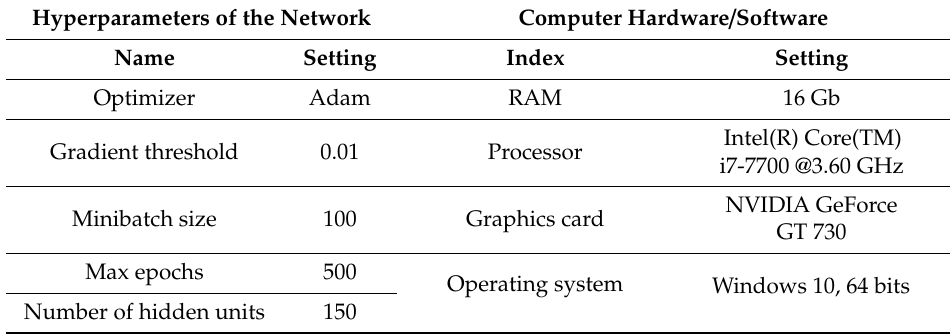
Table 5. The hyperparameters of the LSTM-based network and the computer configuration parameters.